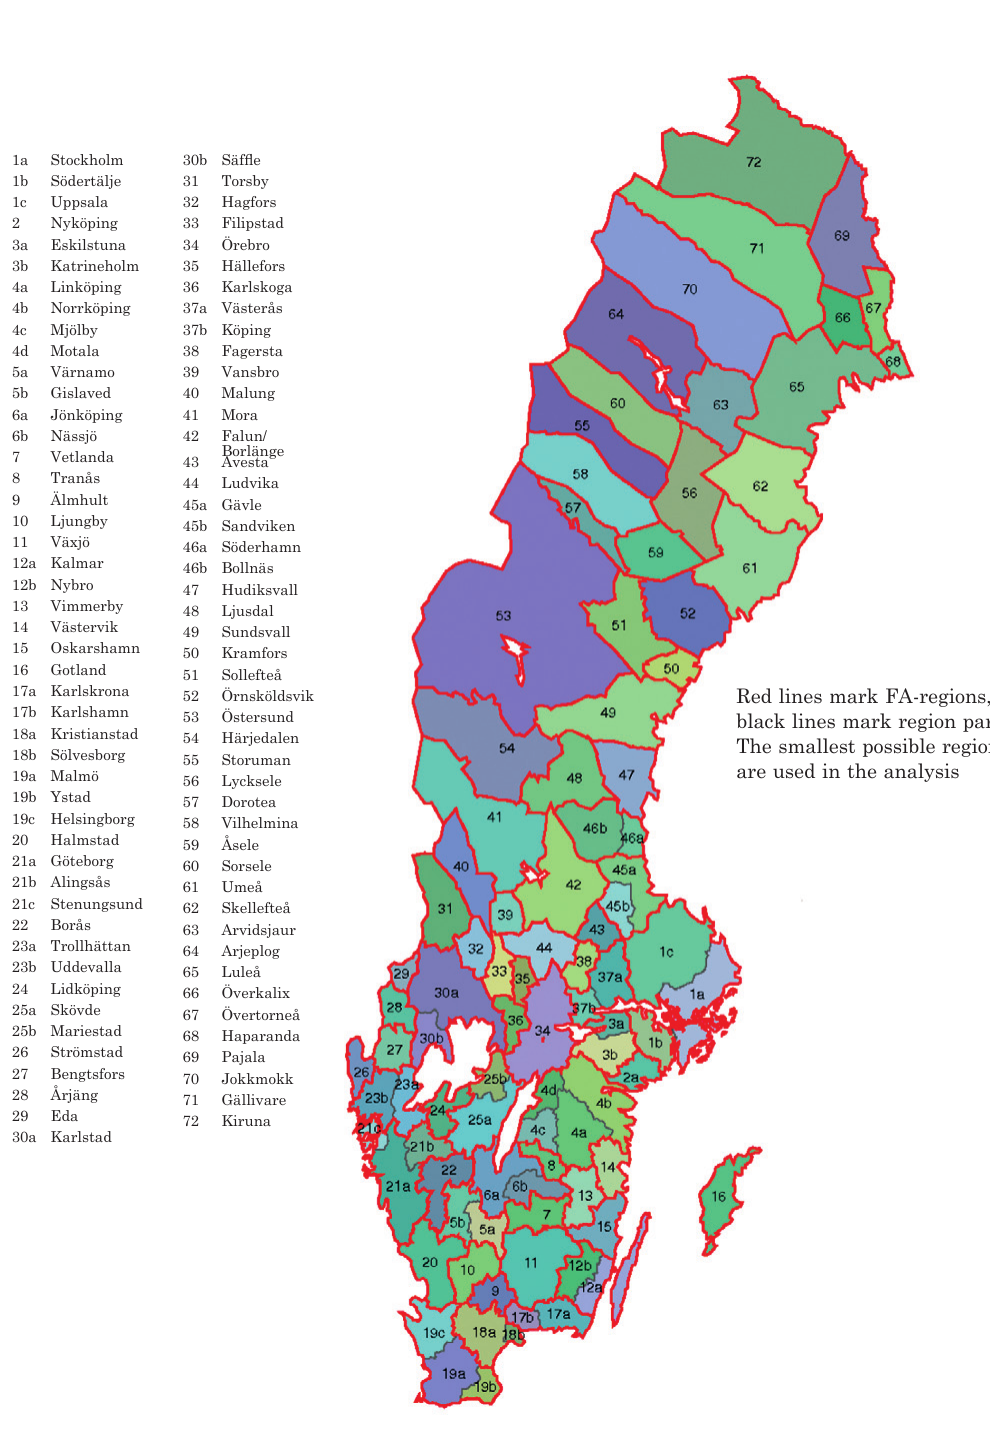
Figure 9. Map of FA-regions and region parts